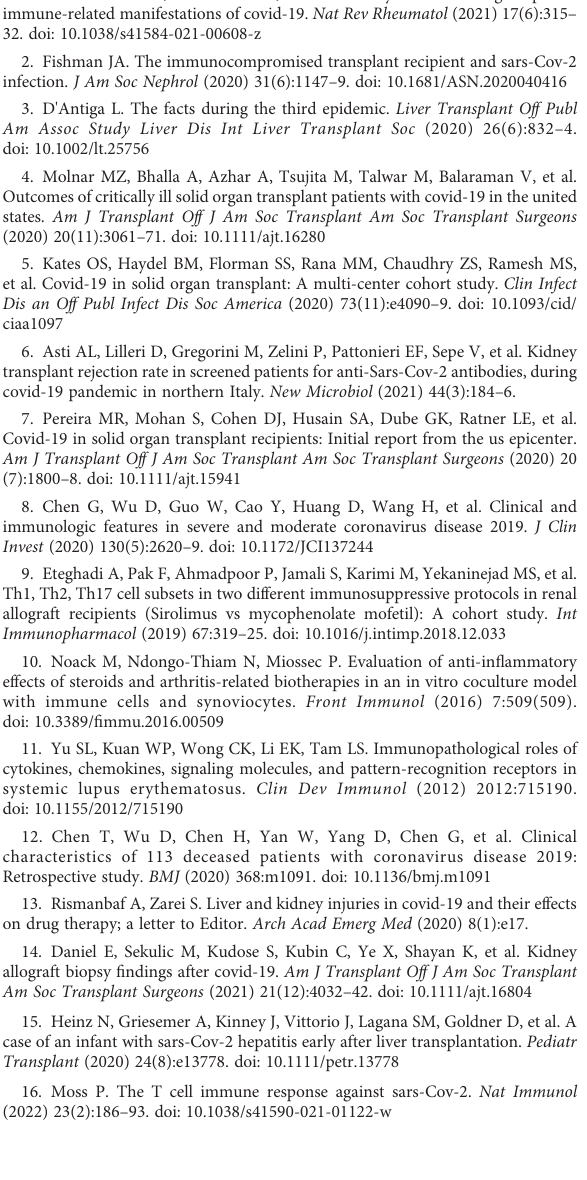
SUPPLEMENTARY FIGURE 5 (A) Association of cumulative frequencies of COVID-associated TCRs vs total TCRs appeared in both allograft and native tissues within native lung is shown. Linear regression R 2 = 0.27. (B) Association of cumulative frequencies of GLIPH2-de fi ned putative SARS-CoV-2-speci fi c TCRs vs total TCRs appeared in both allograft and native tissues within native lung is shown. Linear regression R 2 = 0.3588. (C) Association of cumulative frequencies of COVID-associated and GLIPH2-de fi ned putative SARS- CoV-2-speci fi c TCRs vs total TCRs appeared in both allograft and native tissues within native lung is shown. Linear regression R 2 =